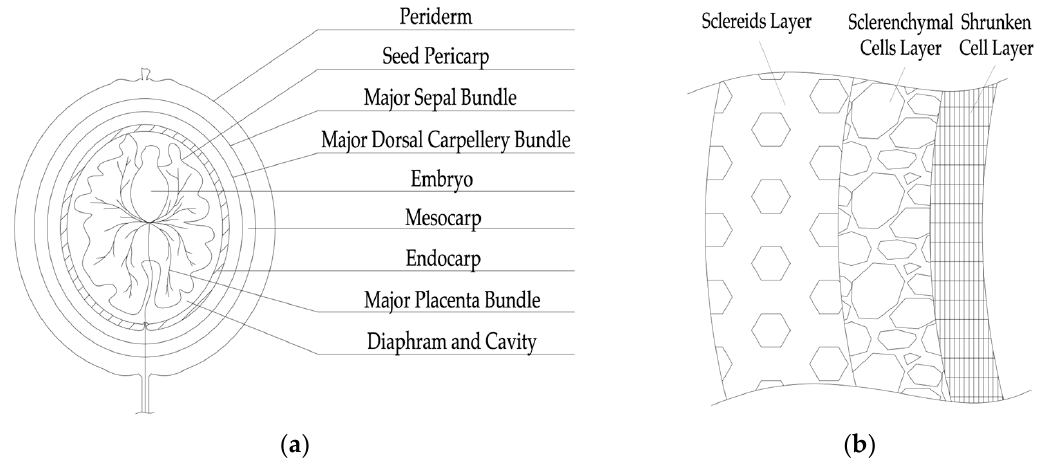
Figure 1 . Walnut: ( a ) fruit structure; ( b ) schematic diagram of the microstructure of a hard shell.